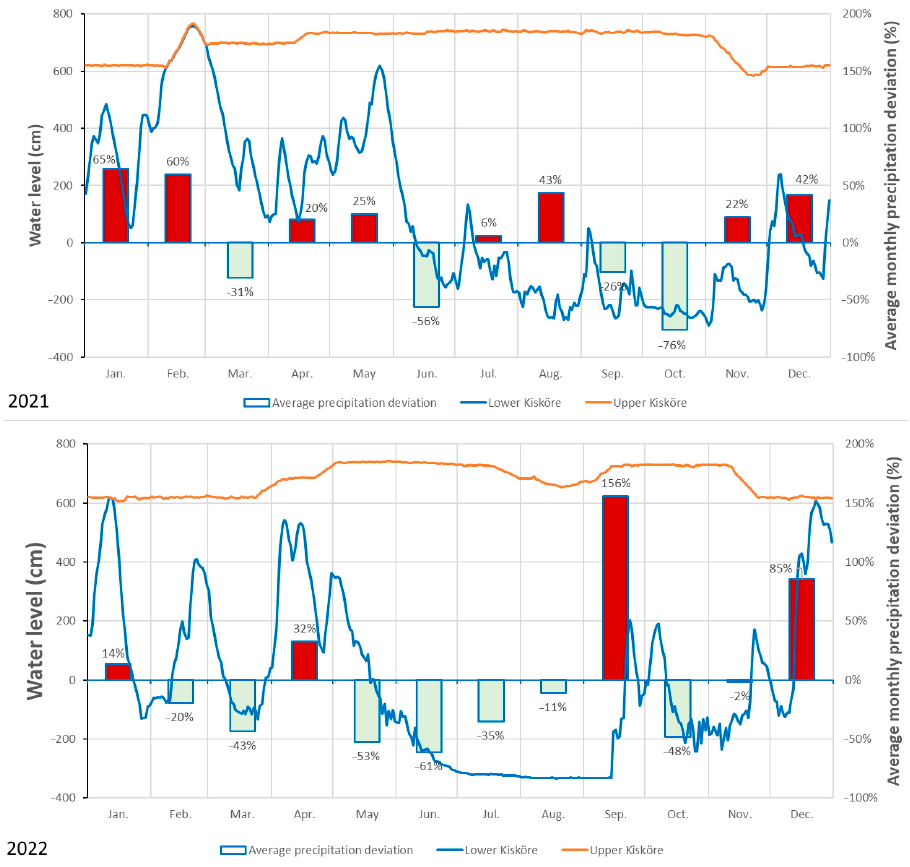
Figure 2. Deviation of water level data and monthly rainfall in the Kisköre Reservoir from the long-term average in 2021 and 2022.